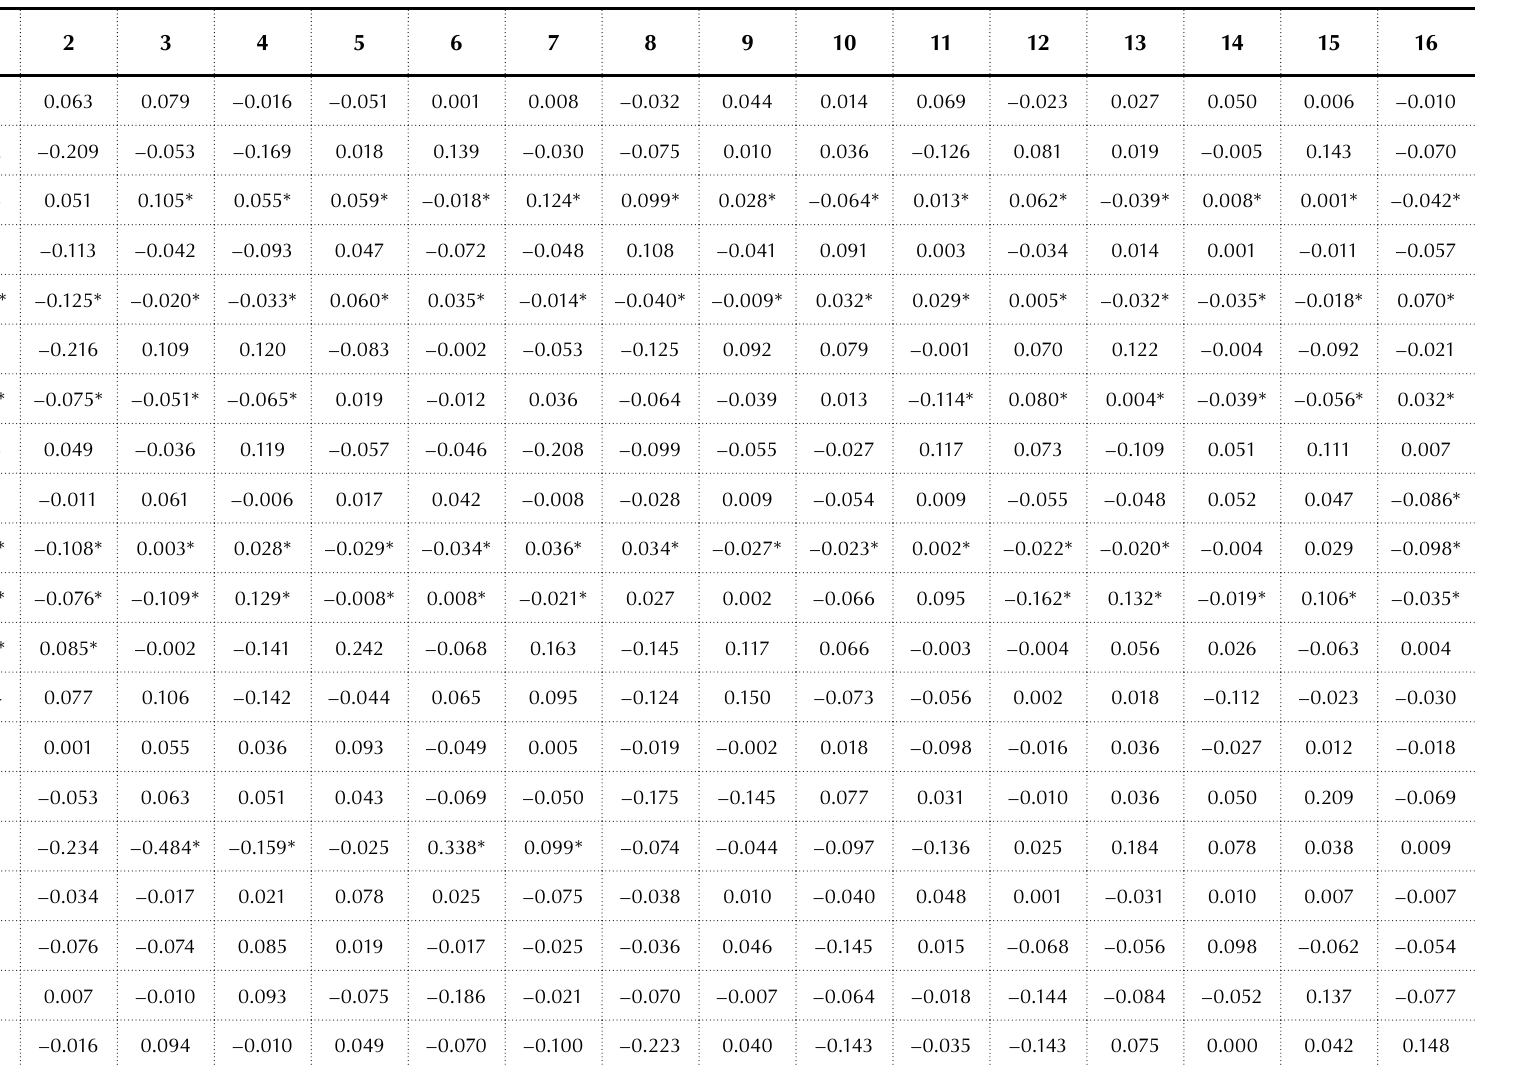
Table 4. Results of autocorrelation of individual